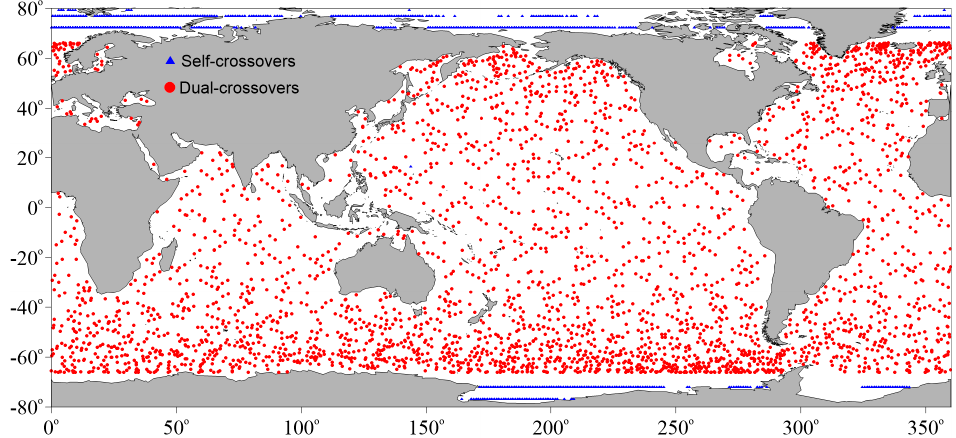
Figure 1. The spatial distribution of self-crossovers of Sentinel-3A (blue) and dual-crossovers between Sentinel-3A and Jason-3 (red).